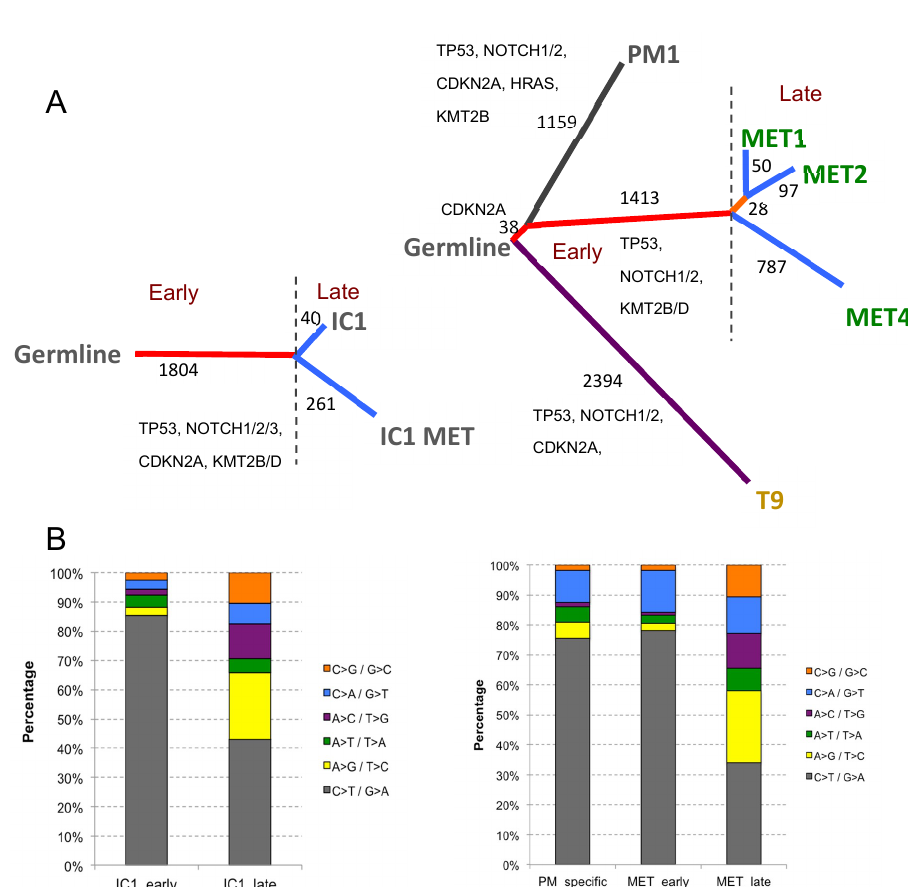
Figure 4. Phylogenetic analysis and mutational signatures of two isogenic cell line series. The numbers of non‐synonymous truncal and branch mutations are indicated ( A ). A significant ( p < 0.0001) decrease in C > T transitions accompanied by a significant ( p < 0.0001) increase in A > G transitions was observed during the evolution of both tumour series ( B ). IC1 / IC1MET, paired primary and metastatic cSCC from an immunocompetent individual; MET1 / MET2 / MET4, cell lines derived from a primary cSCC and its recurrence and metastasis, respectively, from an immunosuppressed organ transplant recipient; PM1, premalignant cell line generated from dysplastic skin from the same patient; T9, cell line generated from a distinct primary cSCC from the same